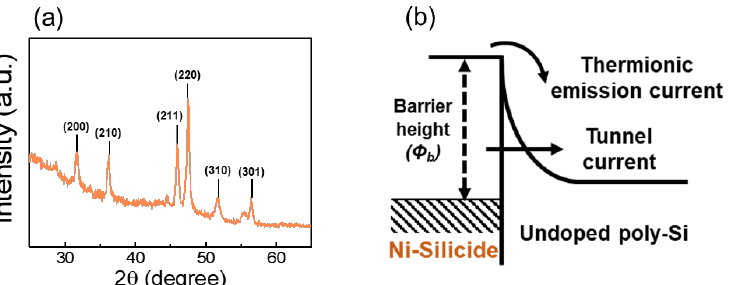
Figure 3. ( a ) X-ray diffraction pattern of NiSi S/D film formed by 600 W of microwave irradiation annealing. ( b ) Schematic band diagram of NiSi and poly-Si interface.